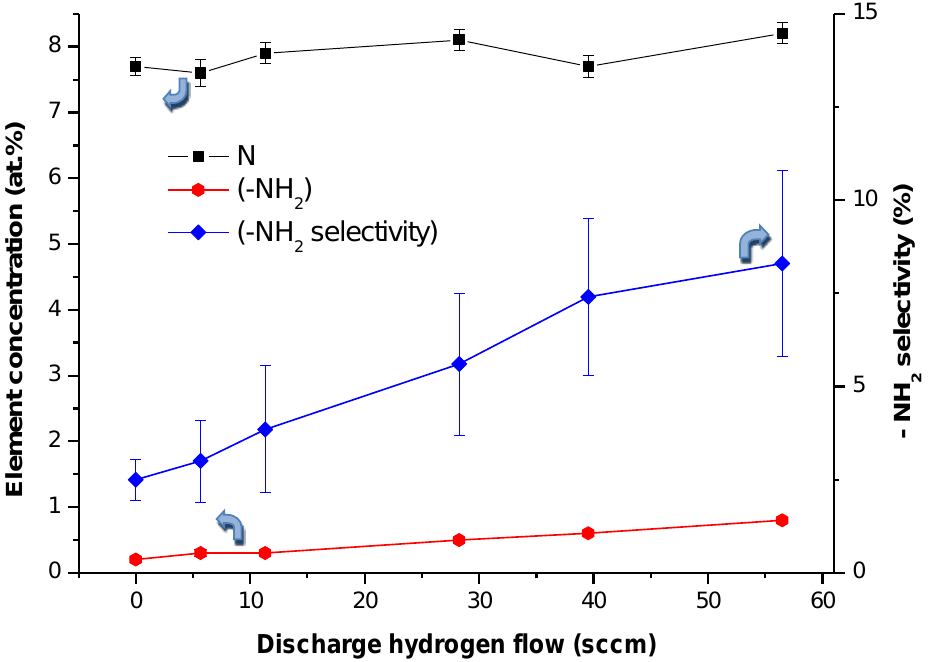
Figure 4. Quantity and selectivity of primary amine groups and nitrogen content in function of H2 flow introduced in the post-discharge chamber.